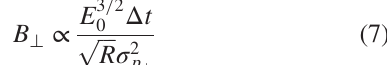
be done on the basis of the 6D brightness, taking into account also bunch length and uncorrelated energy spread.